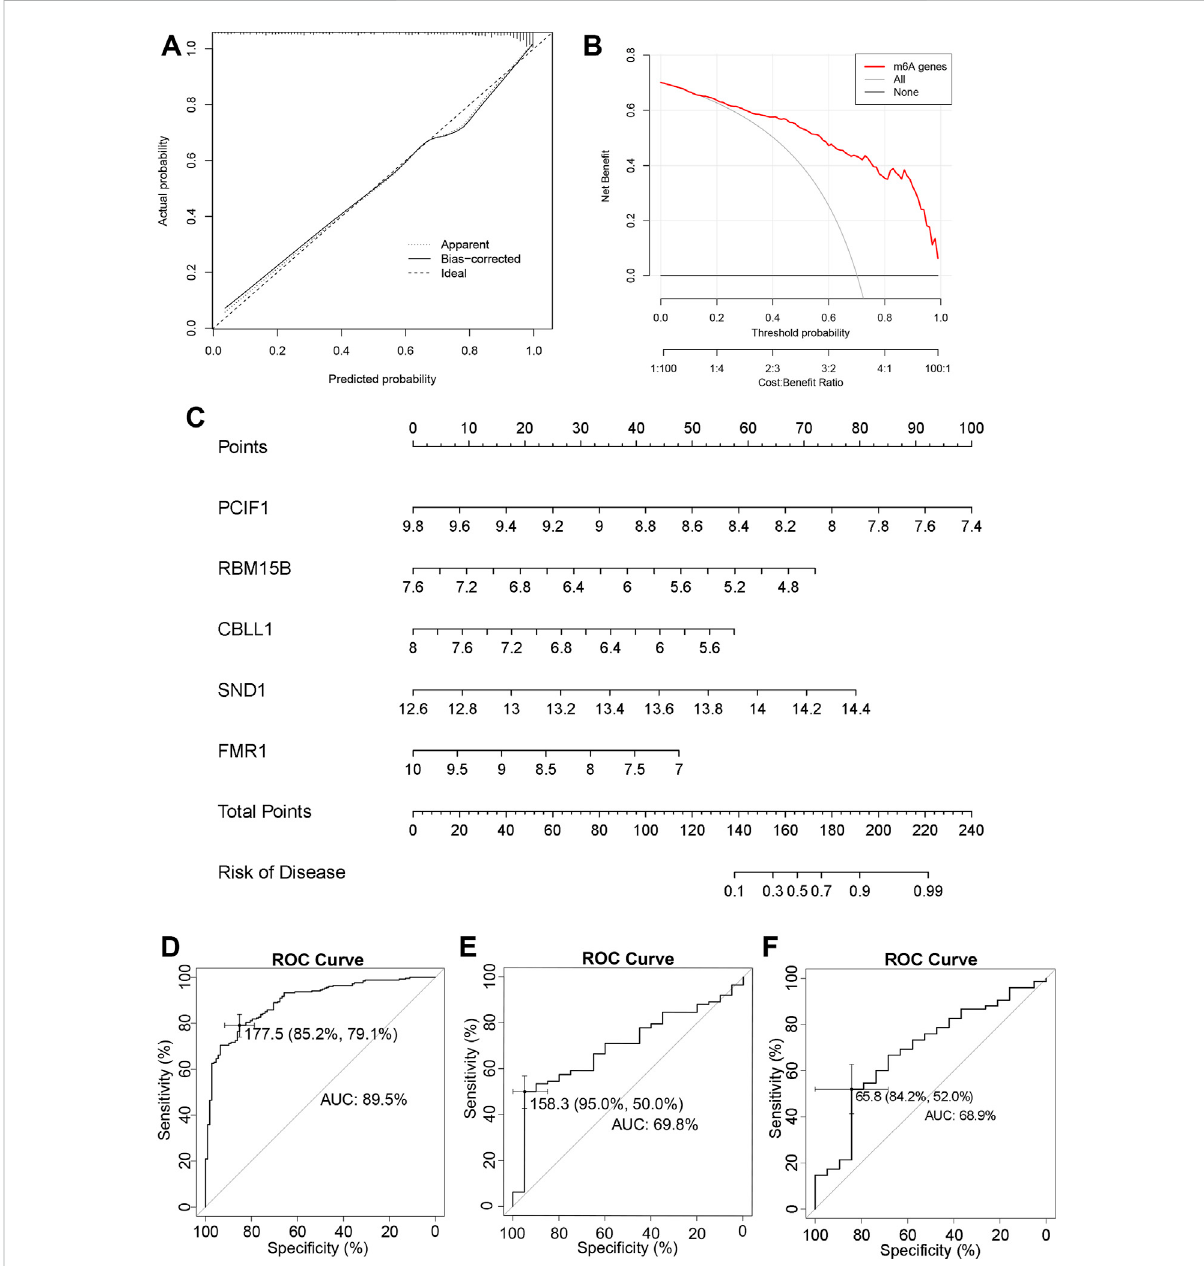
FIGURE 2 Nomogram to build the prevalence model of IPF (A) The calibration curve of the nomogram. (B) DCA of the nomogram. (C) Nomogram of predicted prevalence according to gene score of GSE47460 series. (D) Nomogram predicting the ROC of prevalence in the GSE47460 series. (E) Nomogram predicting the ROC of prevalence in the GSE70866 series. (F) Nomogram predicting the ROC of prevalence in the GSE28221